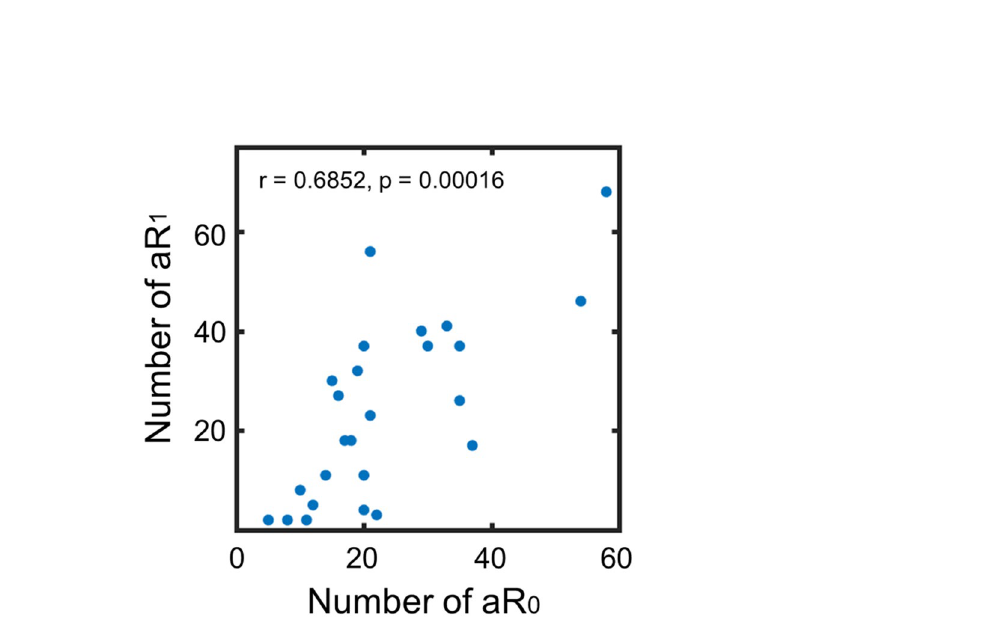
Figure 2. The number of aR 0 was related to that of aR 1 . The number of aR 0 had a positive correlation with the number of aR 1 (r = 0.6852, p = 0.00016, Spearman’s